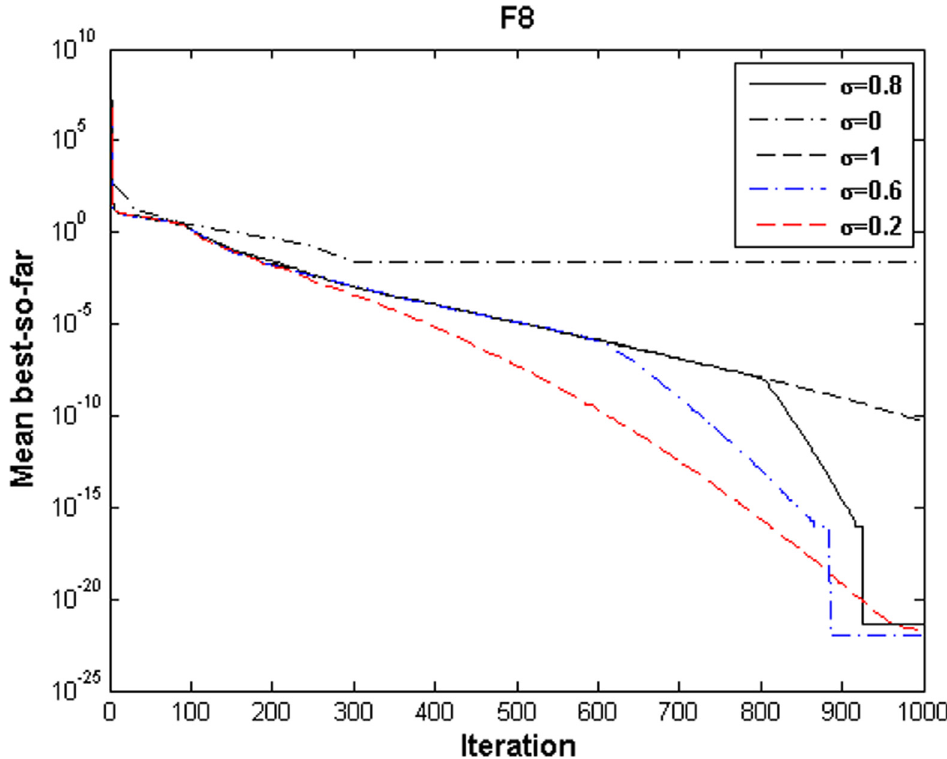
Fig 3. Performance comparison of different values of σ for multimodal